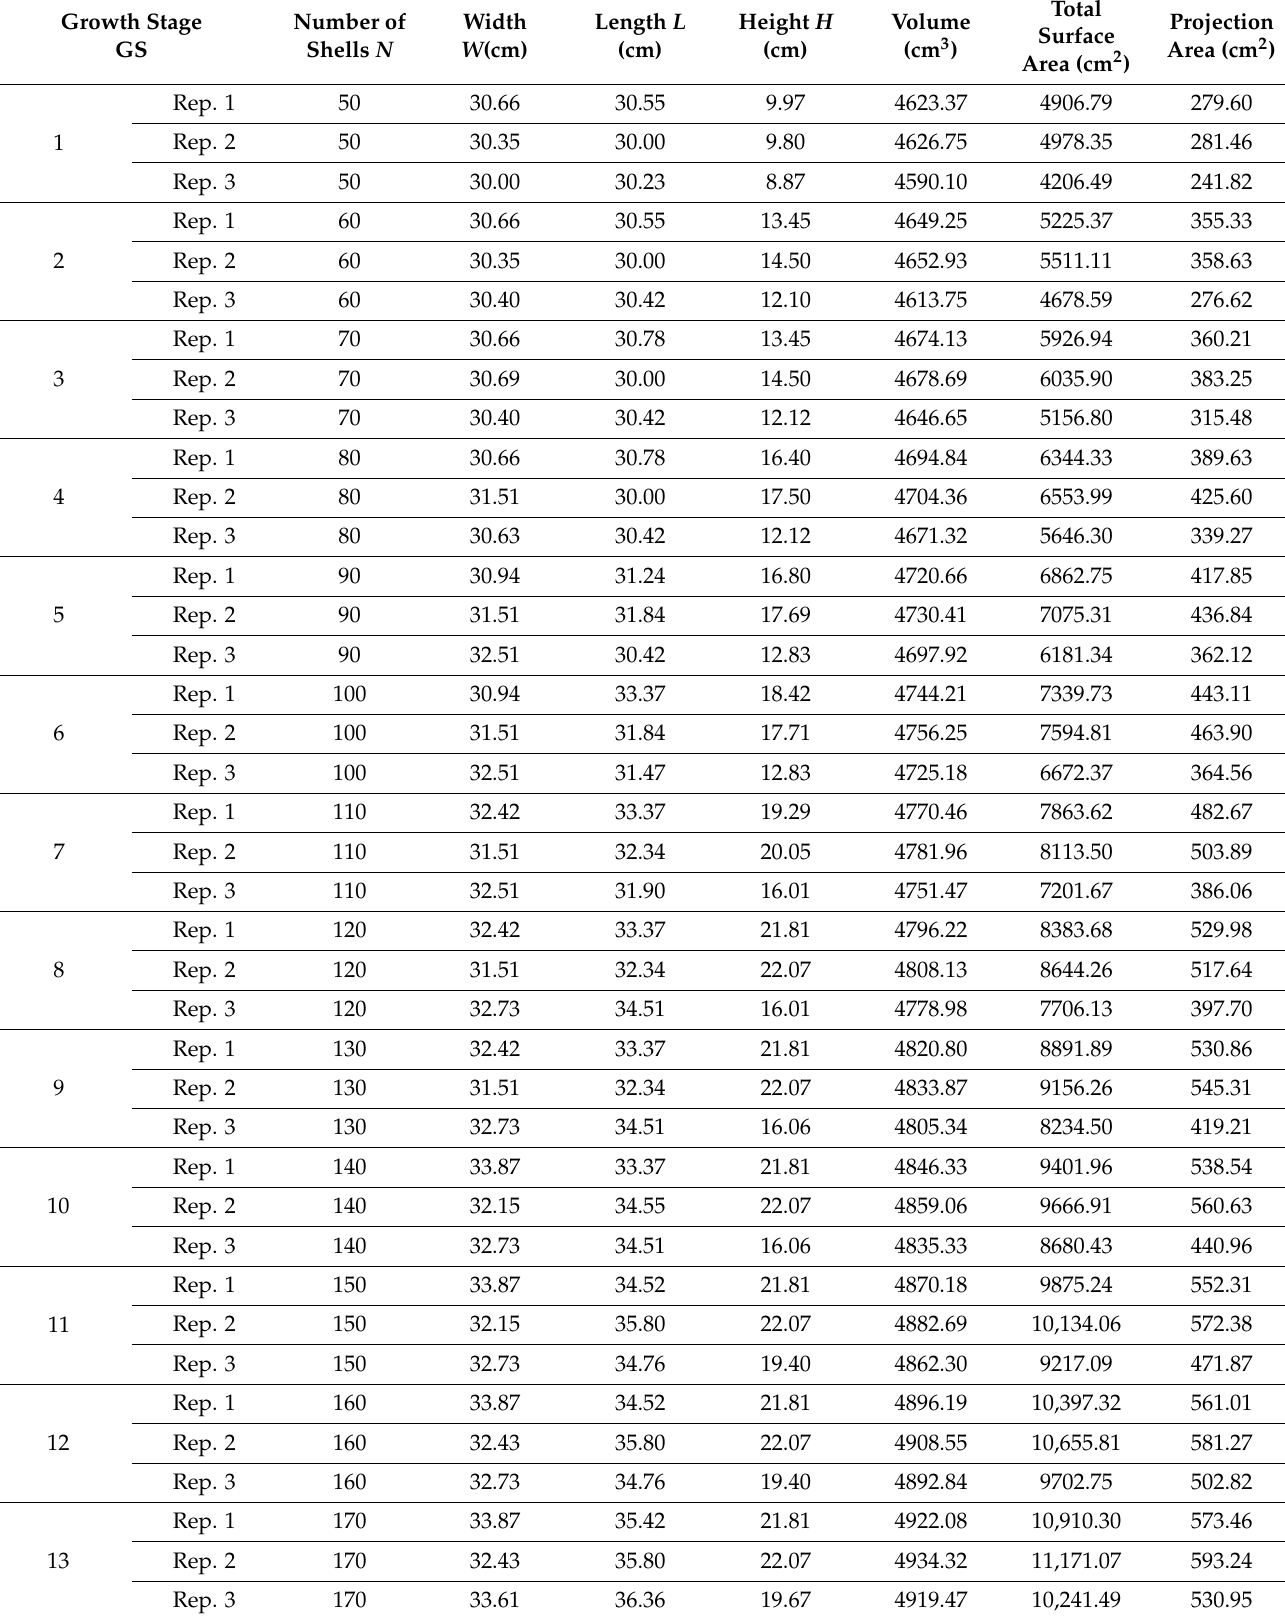
Table 2. Growth stages of the growth AOR models (to be